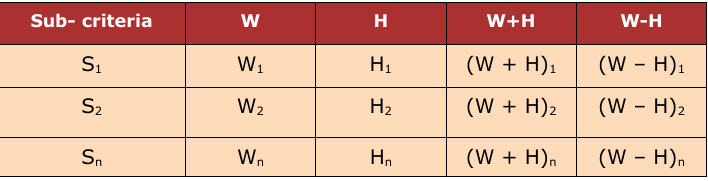
Table 6. Degree of central role matrix